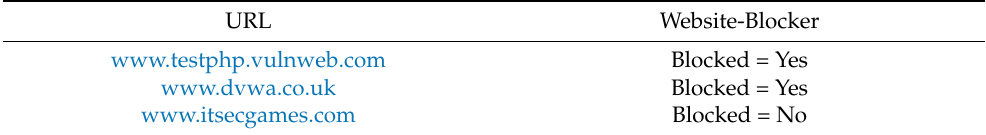
Table 3. URL blocked or not on private browser.